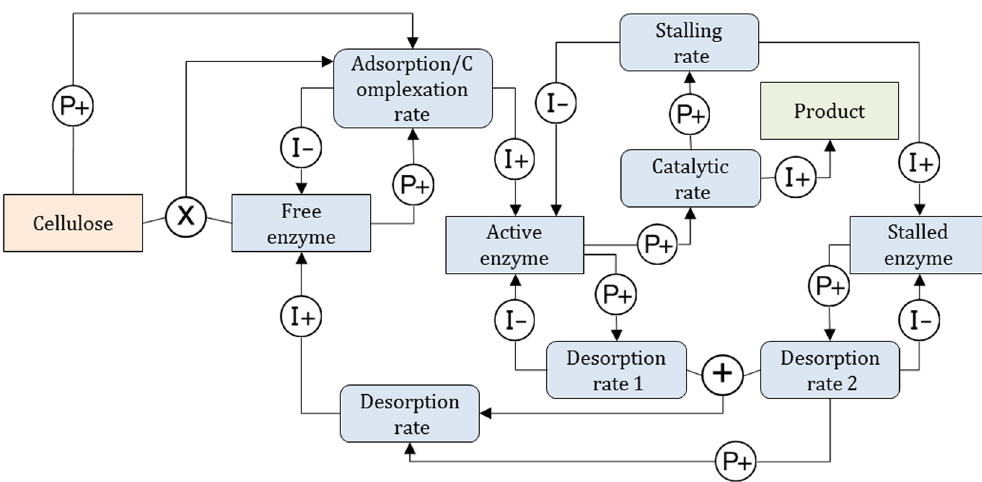
Figure 9. Qualitative Reasoning Model M2 for stalling of enzyme. Relationship with the numerical model (Eq. 3) is given in Table 5. Orange denotes substrate-related quantities, blue-grey is used for enzyme related quantities, and green denotes product related